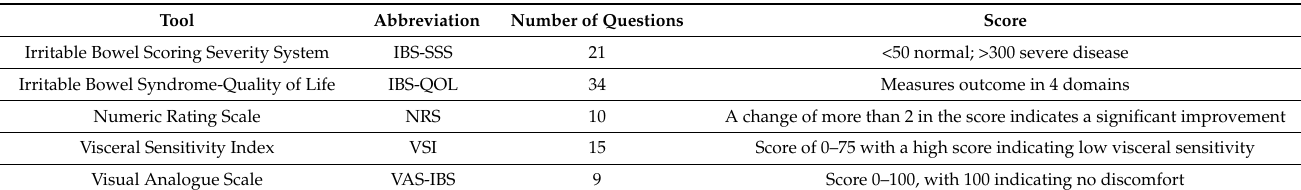
Table 2. Characteristics of some commonly used